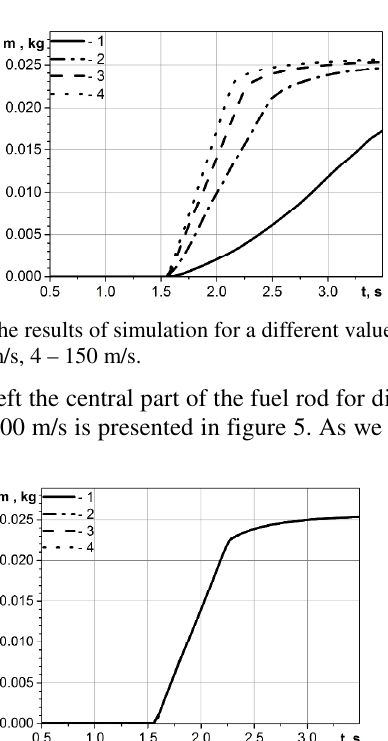
Fig. 5. The mass of the melt. The results of simulation for a different value of the contact angle. 1 – 70 deg; 2 – 90 deg ; 3 – 110 deg ; 4 – 130 deg